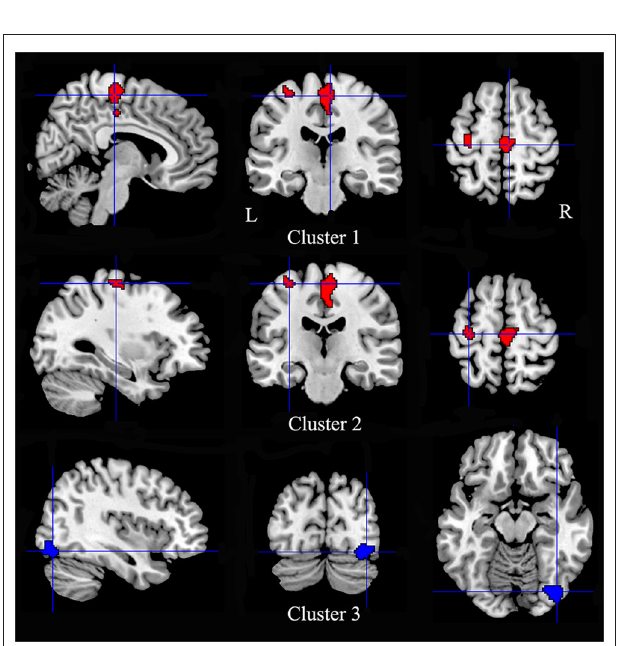
FIGURE 4 | Regions showed conjoint structural and functional alterations in idiopathic blepharospasm compared with healthy controls. Patients with iBSP showed increased GM and hypoactivity relative to healthy controls in bilateral SMA and bilateral paracentral lobules (Cluster 1), and left precentral gyrus (Cluster 2). Right inferior occipital gyrus and fusiform gyrus showed GM decrease with hyperactivity (Cluster 3).